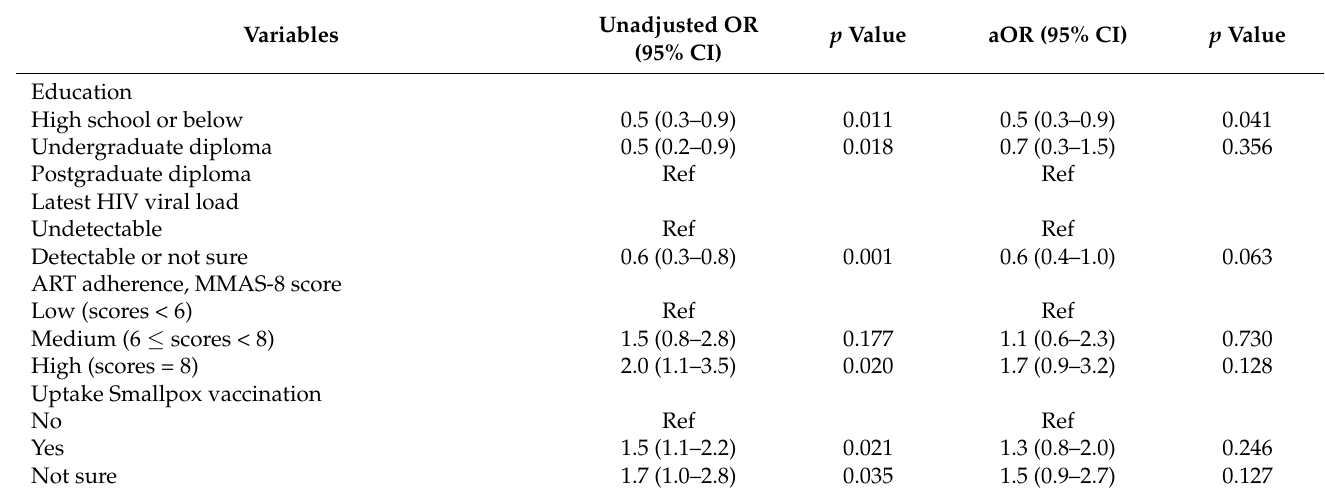
Table 4. Correlates of Mpox vaccination willingness among MSM living with HIV in